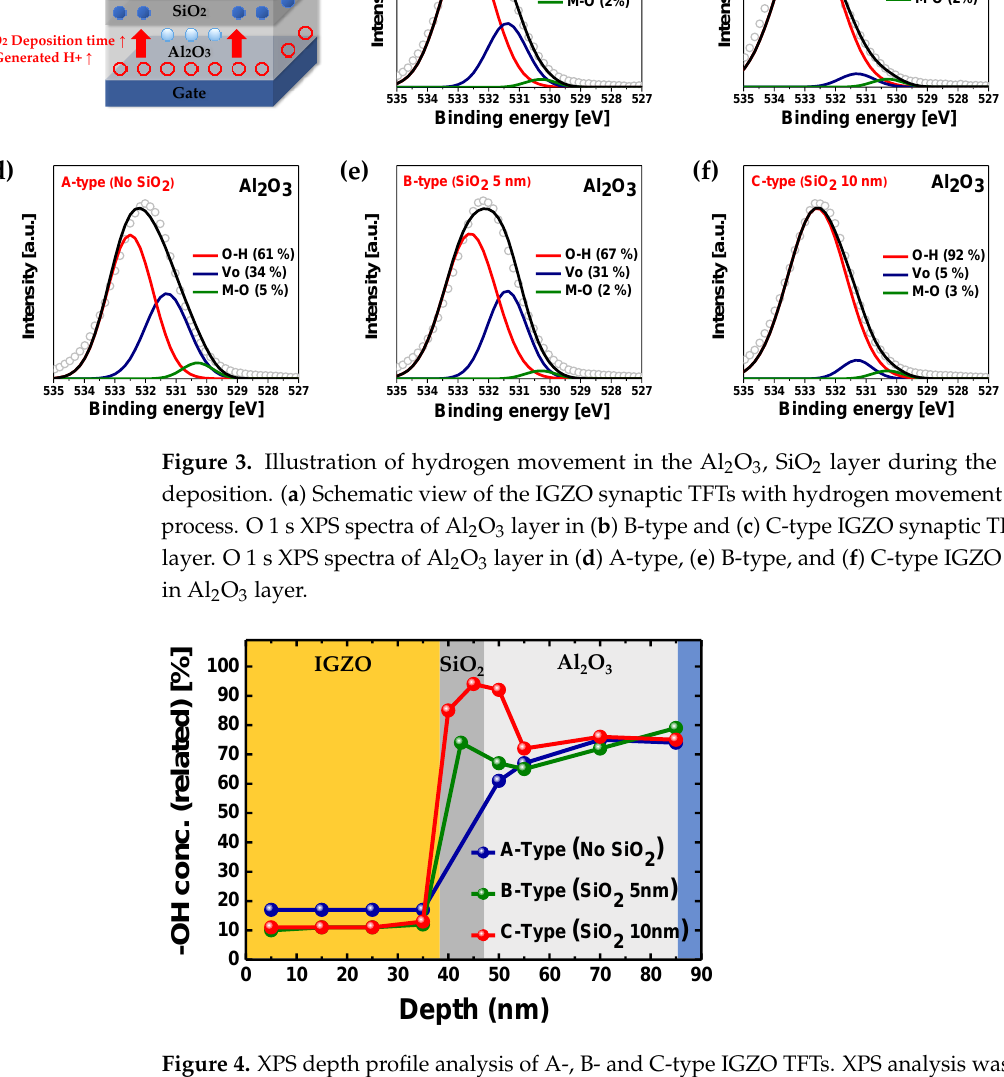
Figure 4. XPS depth profile analysis of A-, B- and C-type IGZO TFTs. XPS analysis was performed at 5 nm, 15 nm, 25 nm, 35 nm depth in IGZO layer (all the types), 5 nm, 10 nm depth in SiO 2 layer (B- and C-type only), and 5 nm, 10 nm, 25 nm, 40 nm depth in Al 2 O 3 layer (all the types). The stress-induced instability in the A- and C-type IGZO TFTs is also investigated by applying NBS and PBS at V GS = − 15 V, and 10 V, respectively, for 1.8 ks as shown in Figure 5a,b. The C-type device is considered as potential candidate for synaptic device thanks to high hydrogen content and the A-type device is verified as reference device. The A-type IGZO TFT shows 3.6 V negative V T shift under PBS and 2 V positive V T shift under NBS, which means that hydrogen ions inside the Al 2 O 3 and SiO 2 layer move toward the IGZO channel during PBS but move away from the IGZO channel again during NBS due to negative V GS . Since the C-type IGZO TFT has more hydrogen content than the A-type de- vice due to the additional SiO 2 layer, it shows a larger V T shift under the same stress con- ditions (ΔV T = − 7.9 V/6 V under PBS/NBS). The V T is recovered through NBS in both the A- and C-type devices, but not fully as the initial values since some of hydrogen moving toward the IGZO layer can form a bond with oxygen at the IGZO layer interface [40], and some hydrogen can act as a shallow donor [46]. Therefore, strong NBS condition with larger amplitude than PBS condition is required for sufficient V T recovery.